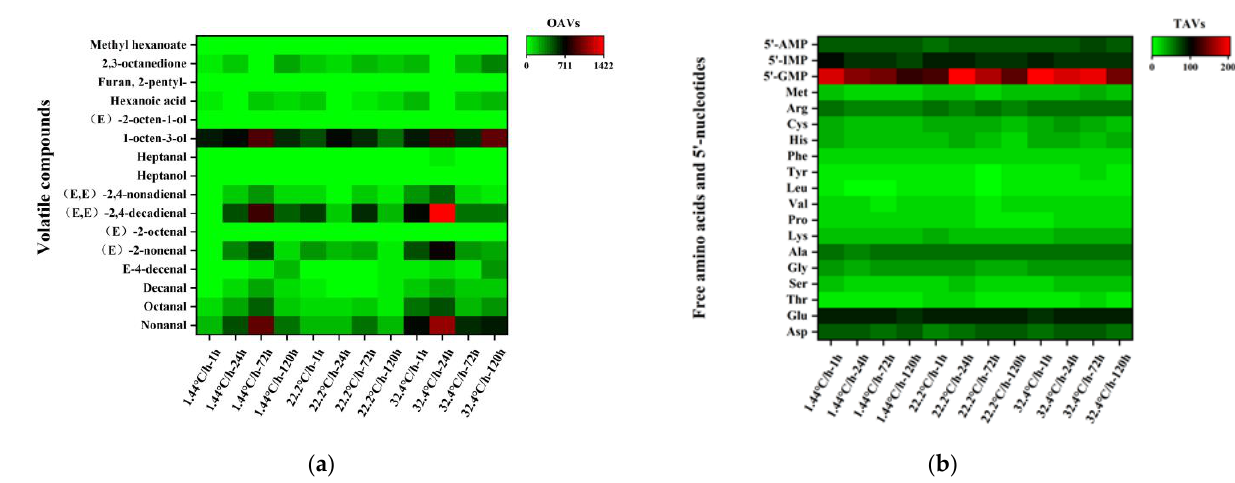
Figure 2. OAVs and TAVs of volatile compounds and non-volatile compounds in raw meat at different chilling rates during refrigeration. ( a ) OAVs of volatile compounds. ( b ) TAVs of non-volatile compounds.